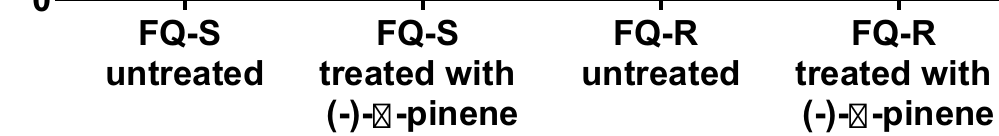
Fig 3. Campylobacter counts (log 10 CFU/g) in the cecum content of broiler chickens following treatments without and with a subinhibitory (-)- α -pinene concentration via direct gavage for 3 consecutive days (0.4 mL, 250 mg/L, daily). The samples were collected 24 h after the last treatment, and cultured for Campylobacter . Data are means ± standard deviation from individual broiler chickens that were colonized with either FQ-S or FQ-R C . jejuni prior to the treatment. FQ-S/FQ-R untreated, fluoroquinolone- sensitive/resistant C . jejuni (controls); FQ-S/FQ-R treated, fluoroquinolone-sensitive/resistant C . jejuni plus treatment with (-)- α - pinene. � p <